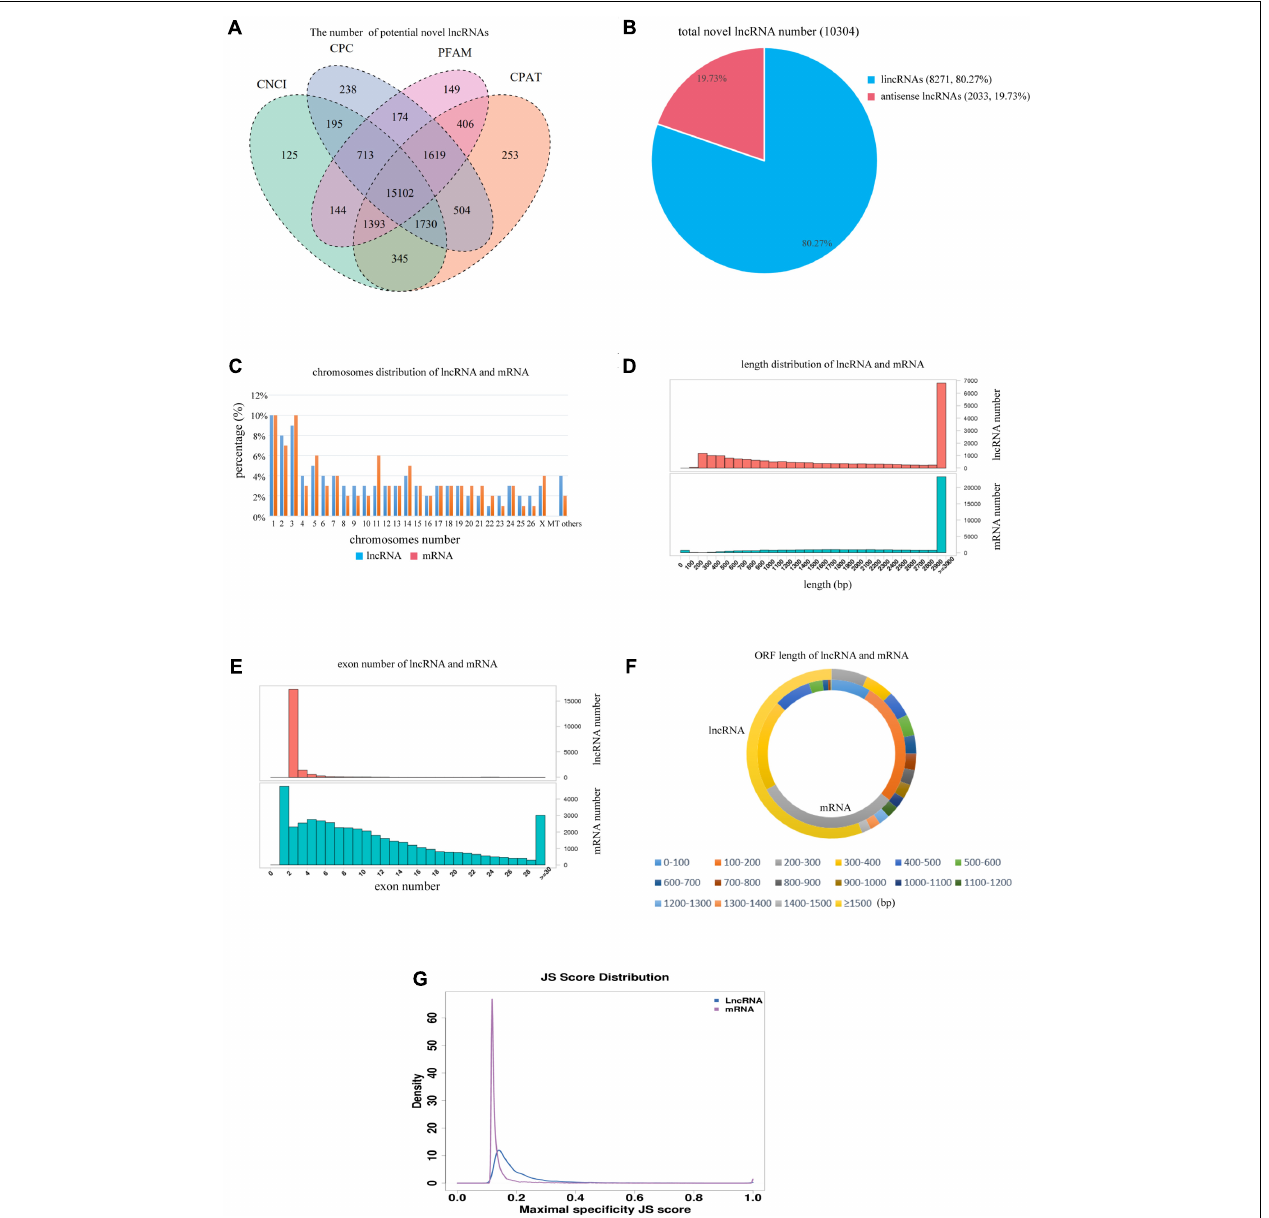
FIGURE 1 | Identification of lncRNAs and mRNAs in Han sheep hypothalamus. (A) Venn showing the common and unique number of novel lncRNAs by four methods, including CNCI, CPC, PFAM, and CPAT. (B) Classification of 10,304 novel lncRNAs, including lincRNAs and antisense-lncRNAs. (C) Distribution of lncRNAs and mRNAs in chromosomes. (D) Length of lncRNAs and mRNAs. (E) Exon number of lncRNAs and mRNAs. (F) Length of ORF of lncRNAs and mRNAs. (G) Tissue specificity of lncRNA and